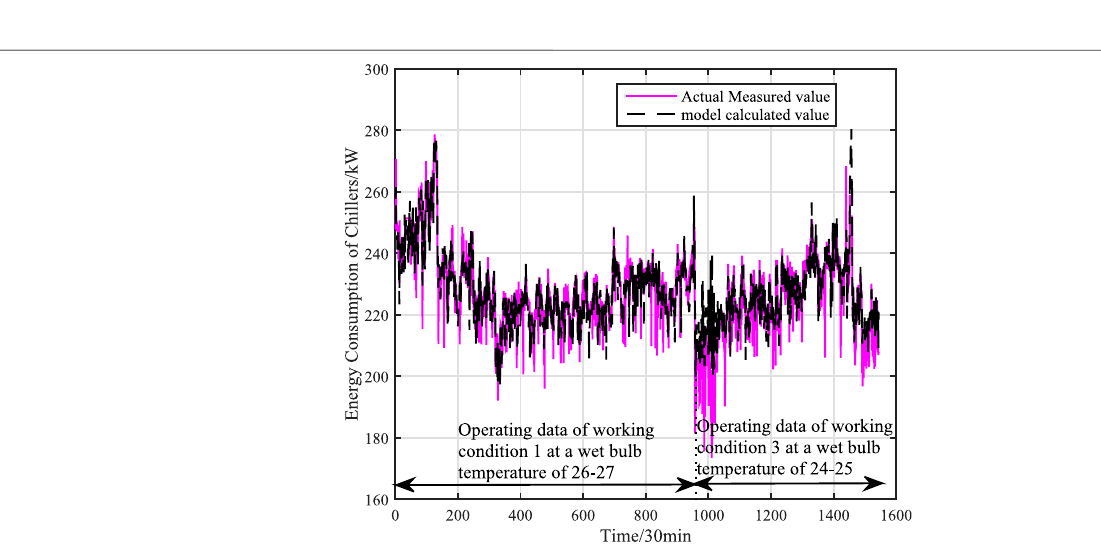
Frontiers in Energy Research |